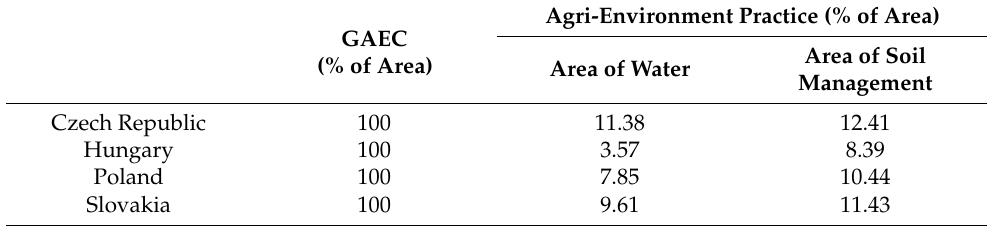
Table 3. Percentage of the Agricultural Area Enclosed Within Mandatory Standards, Compared to Percentage of Agri-environment Contracts on Sustainable Water and Soil Management. Agri-Environment Practice (% of Area) GAEC Area of Soil (% of Area) Area of Water